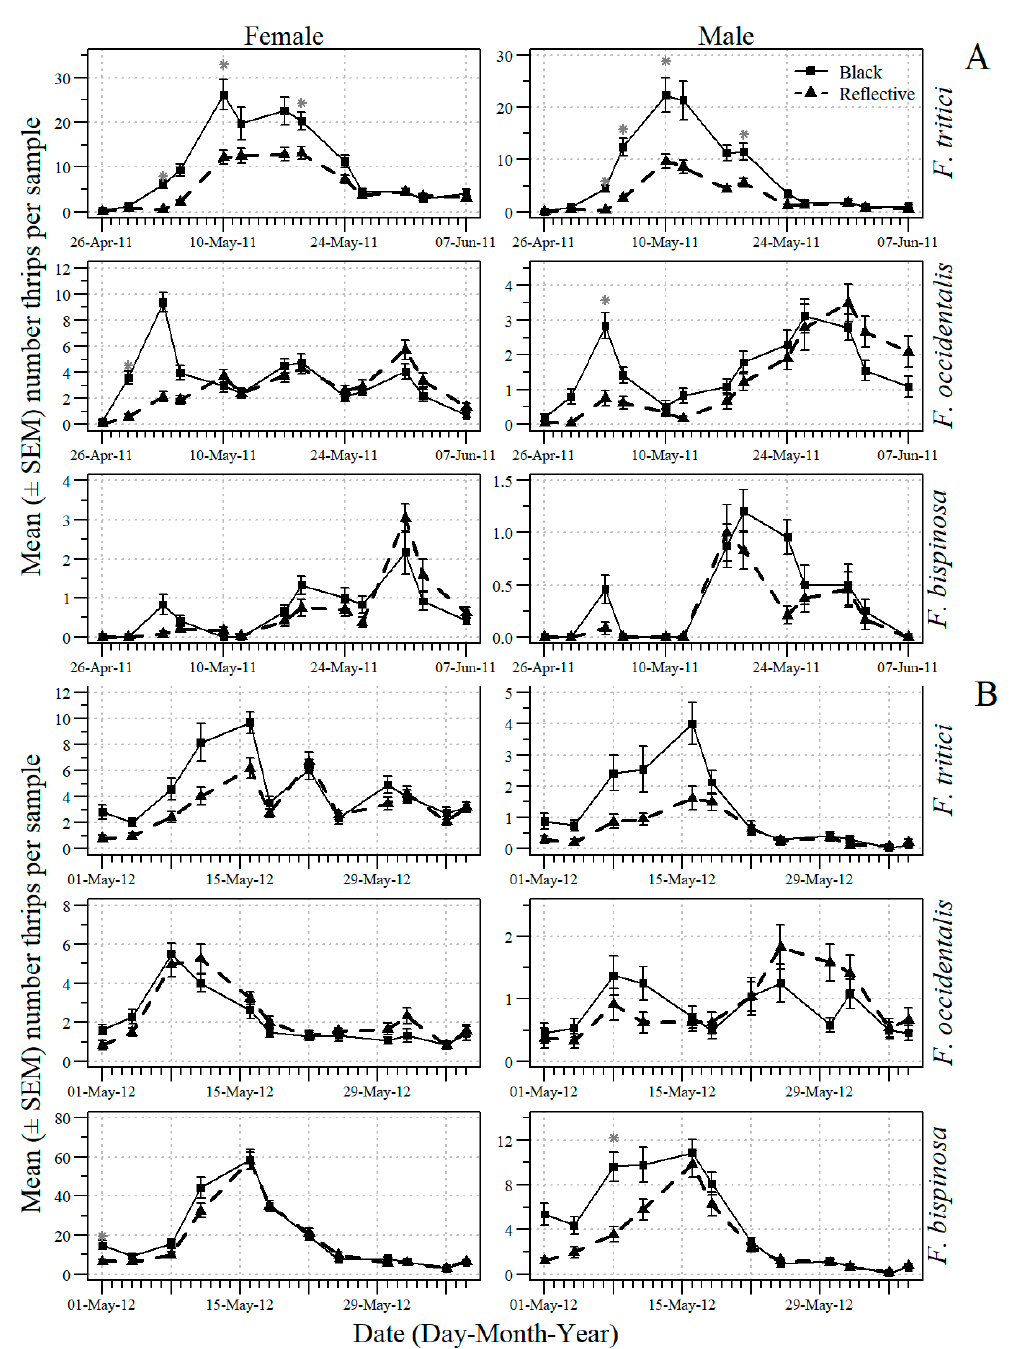
Figure 1. The mean number (+SEM) per 10 tomato flowers (n = 18 samples) of adult male and female F. occidentalis , F. bispinosa and F. tritici on each 2011 ( A ) and 2012 ( B ) sample date in the whole plot treatments of black and UV-reflective mulch for data pooled across kaolin and companion plant treatments in the experiments conducted in Gadsden County, Florida (* indicates significance beyond 95% level according to analysis of variance conducted for individual sample dates; d. f. = 1, 2).